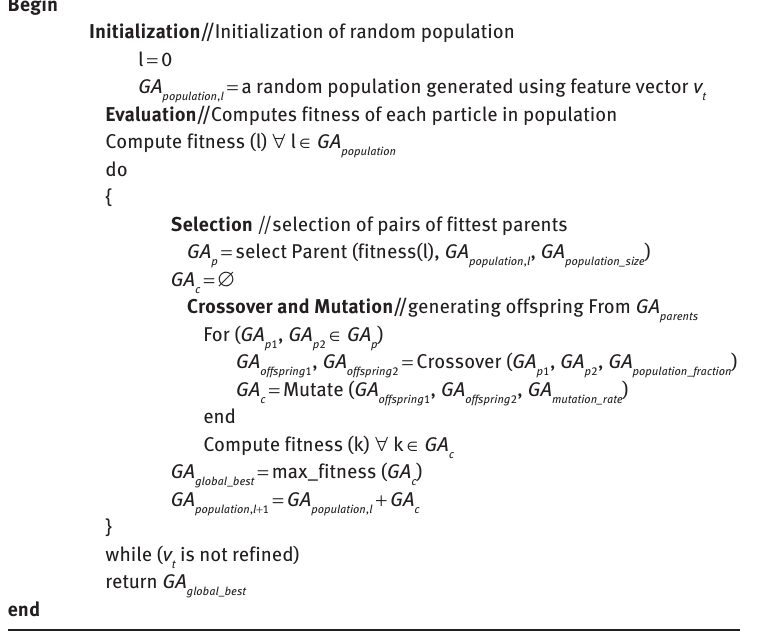
, GA mutation_rate